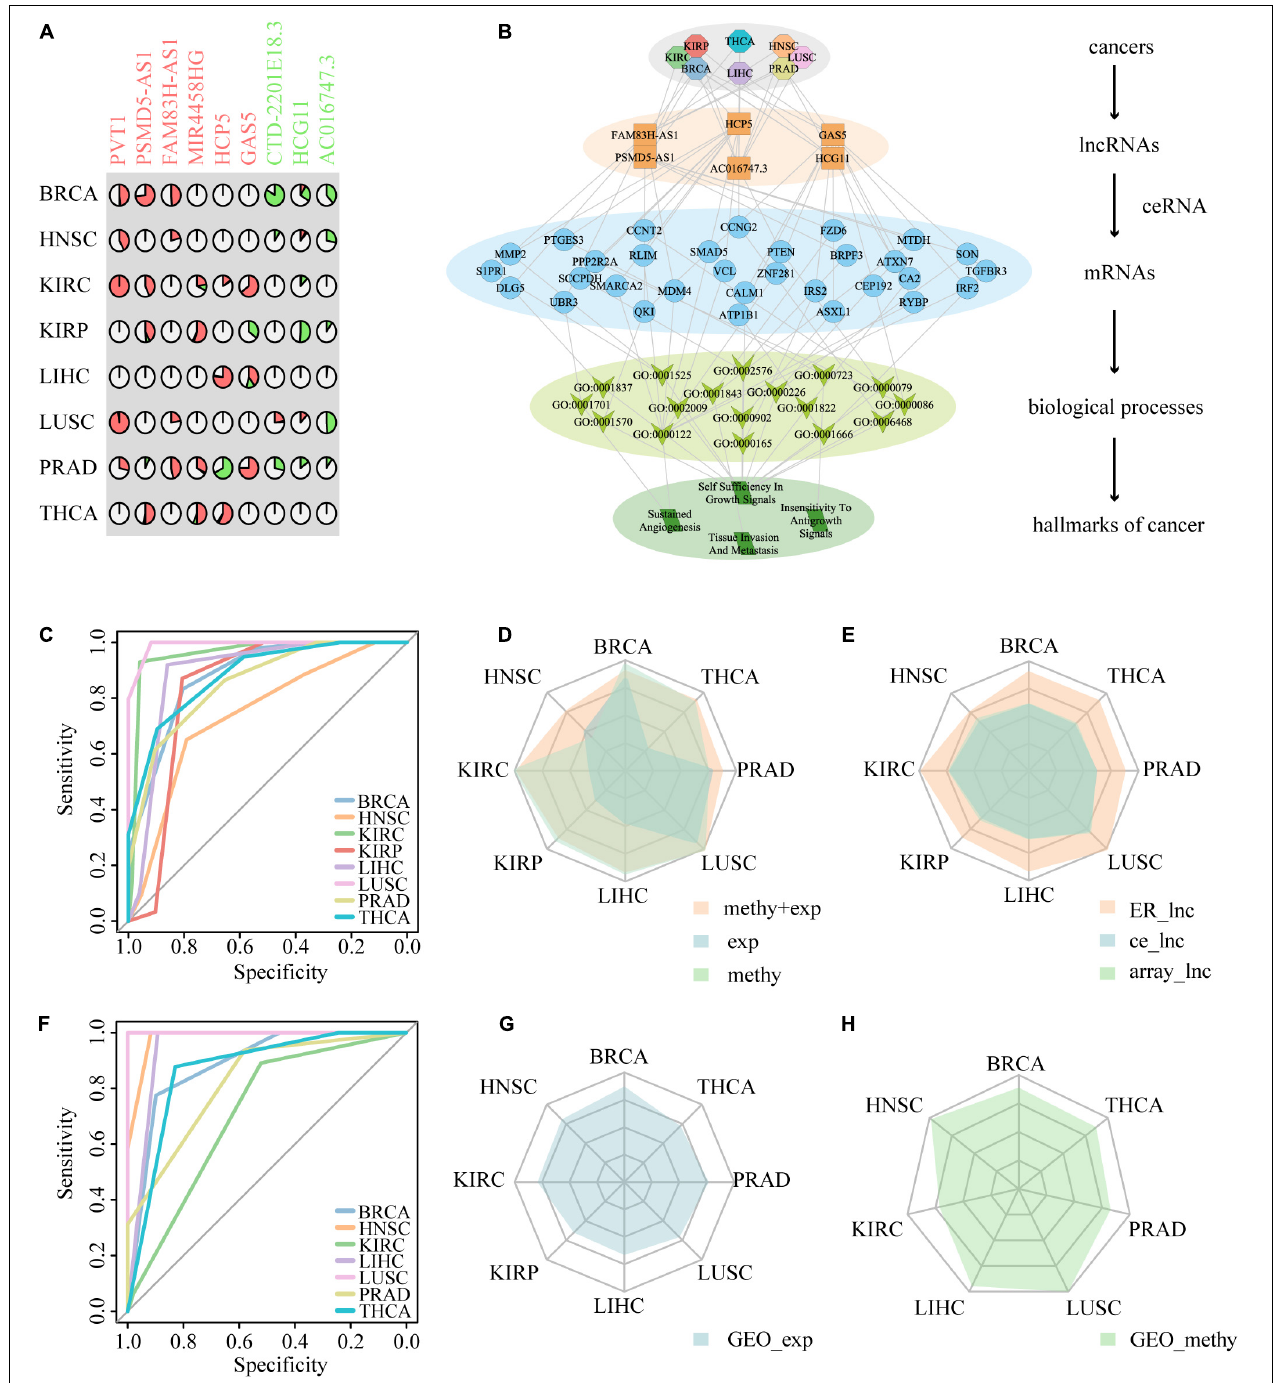
FIGURE 6 | The performance of nine ER lncRNAs in distinguishing cancer patients from normal samples. (A) The layout of nine ER lncRNAs. The symbol of lncRNAs with red color represents the lncRNA epigenetically activated in pan-cancer, and the symbol of lncRNAs with green color represents the lncRNA epigenetically silenced in pan-cancer. (B) Summary of the hierarchical model to systematically understand the function of ER lncRNAs in DysCeNets. The model is laid out hierarchically with (from the top down) cancers, ER lncRNAs, mRNAs, annotated GO biological process terms, and hallmarks of cancers. (C) The ROC curve of ER lncRNAs based on two-dimensional datasets. (D) The performance of ER lncRNAs classifiers based on TCGA expression, TCGA methylation, and expression combined methylation levels. (E) The comparison of the classifiers among nine ER lncRNAs, nine lncRNAs randomly selected from DysCeNets, and nine lncRNAs randomly selected from expression/methylation profiles. (F) The ROC curve of ER lncRNAs based on the GEO methylation datasets. (G , H) The validated ER lncRNAs classifiers using external expression and methylation GEO datasets.